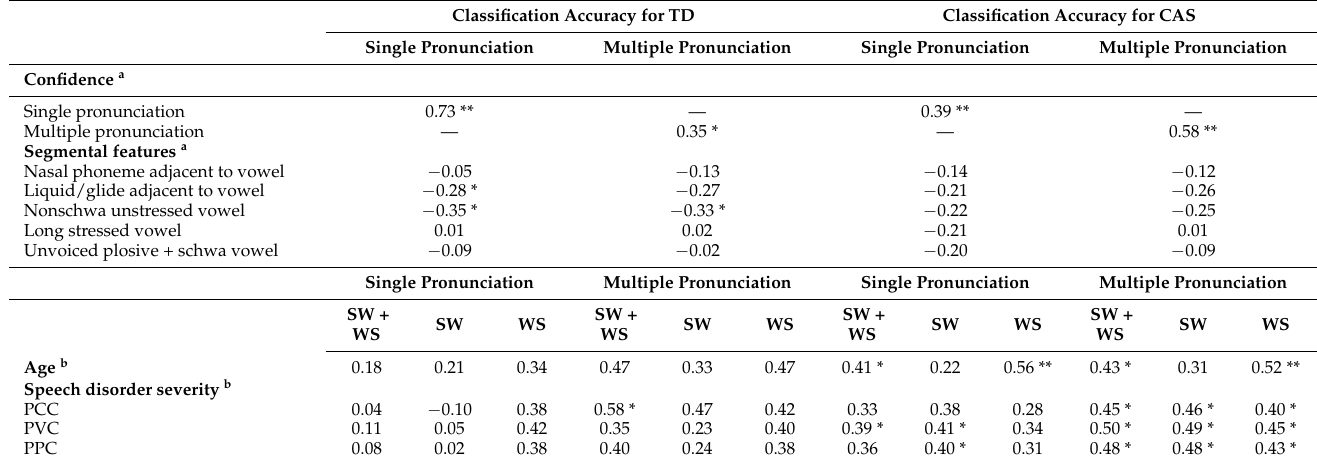
Table 6. Correlation between classification accuracy for words using the single and multiple pronunciation HMM-based forced alignment methods and (a) the tool’s confidence estimates in its classification, (b) within-word segmental features, (c) age, and (d) speech disorder severity metrics for children with typical development (TD) or childhood apraxia of speech